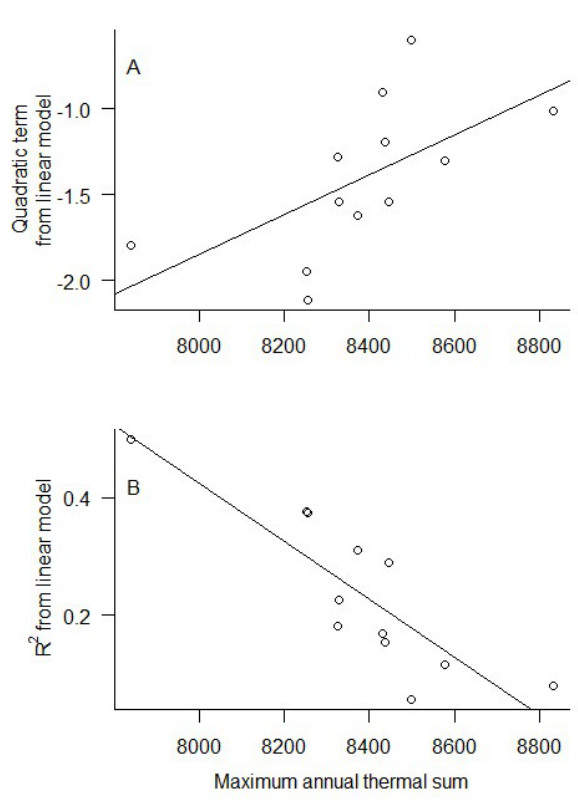
Figure 8. Thermal sum moderates the fit and predictability of seasonality models. Simple linear regressions showing how terms from the linear model vary as a function of thermal sum. In warmer years (i.e., years with greater thermal sum values), butterfly communities are more homogenous and less seasonal; thus, the community composition data vary less as a function of day of the year, here by the quadratic term ( A ) and R 2 ( B ) from annual polynomial regressions of community composition (NMDS) as a function of day of the year. Table 1. AICc table for fixed effects.